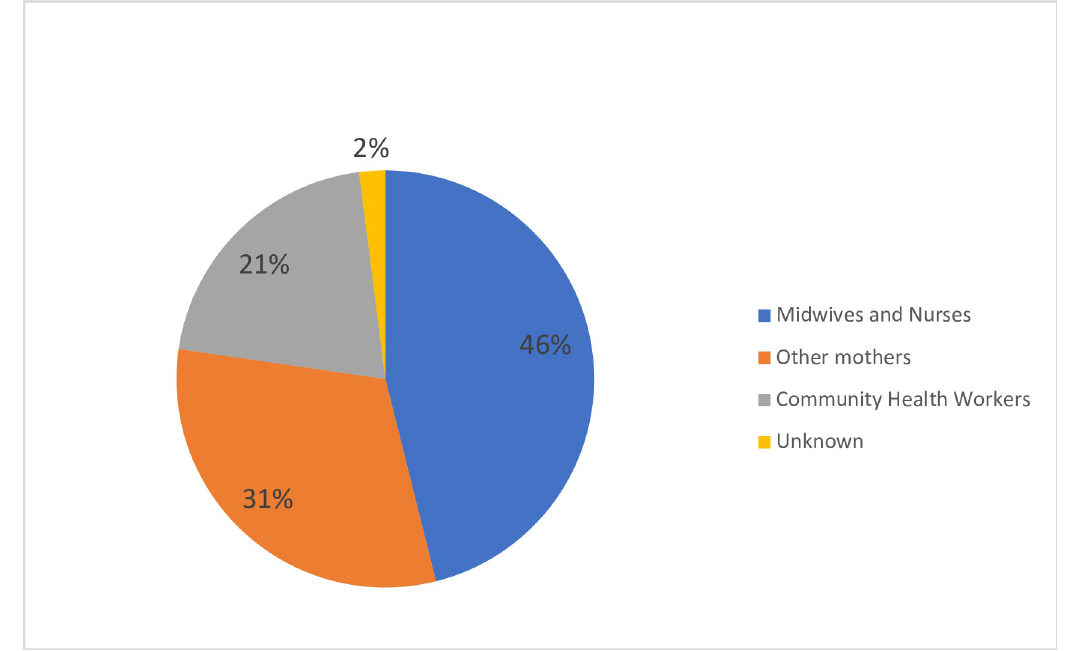
Fig 2. Source of information about obstetric danger signs (n =